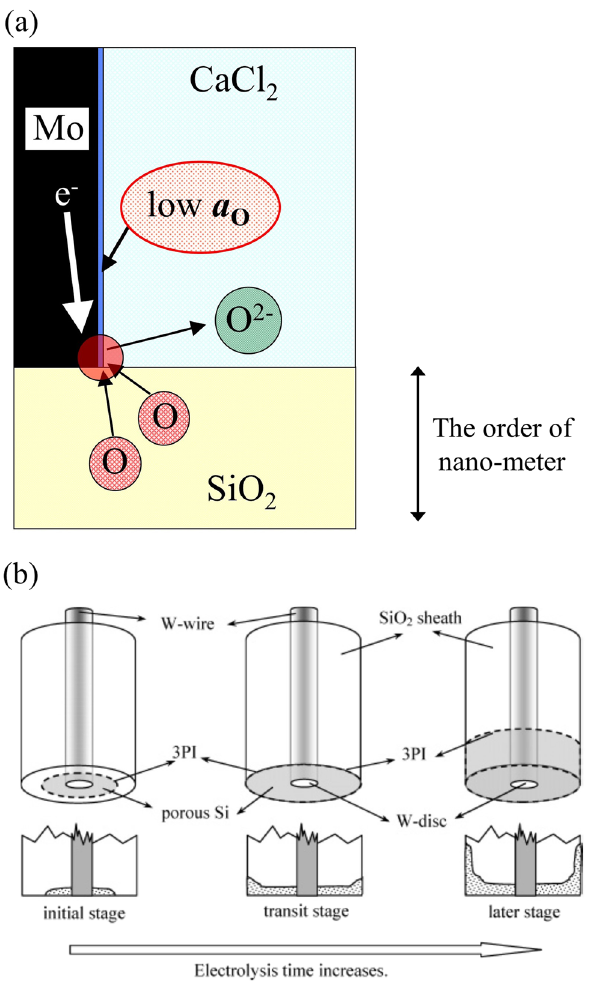
Figure 12: Schematic illustrations of the reaction mechanism pro - posed by using ( a ) a point - contact electrode method [ 203 ] , and ( b ) a SiO - sheathed electrode method [ 210 ] . Permission from 2 Springer Nature and American Chemical